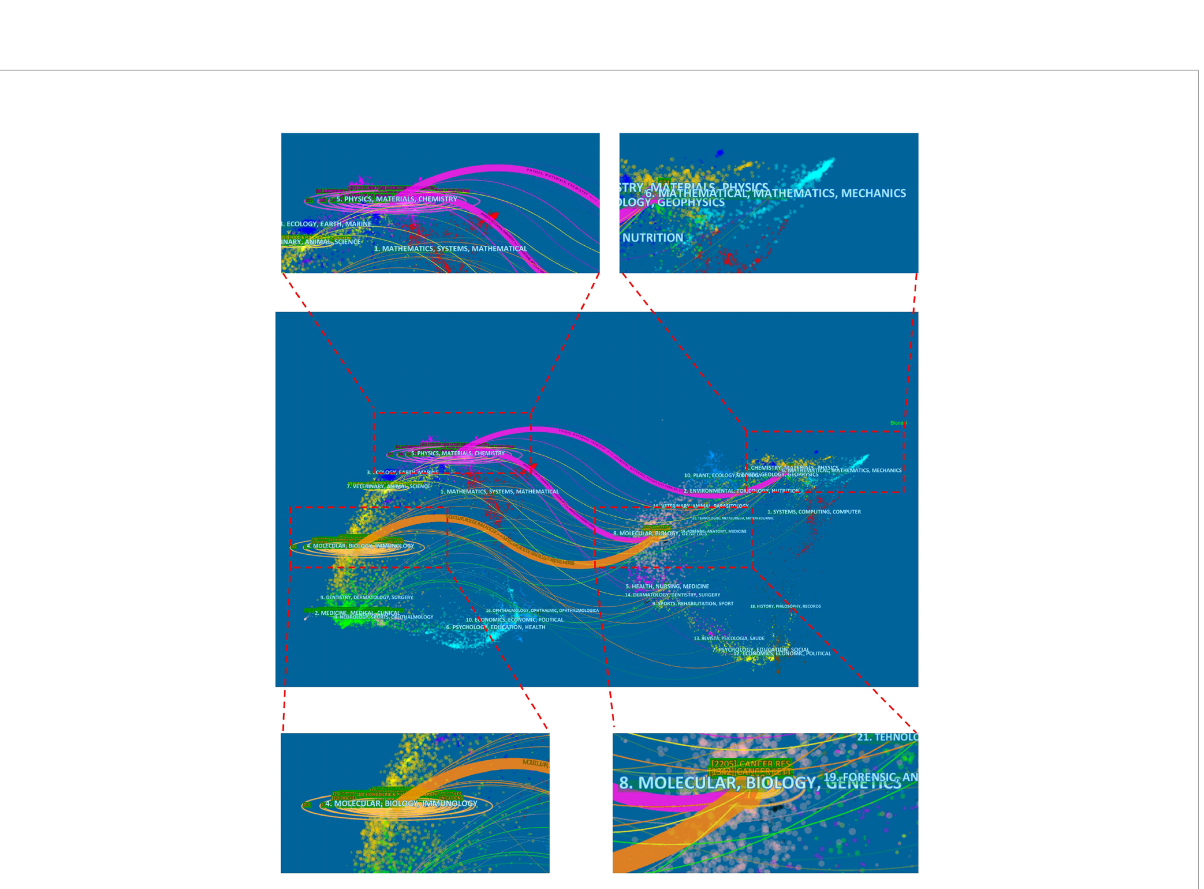
FIGURE 8 The dual-map overlay of articles citing on curcumin and tumor research. (The left side were the citing journal, the right side were the cited journal, and the line path represented the citation relationship).